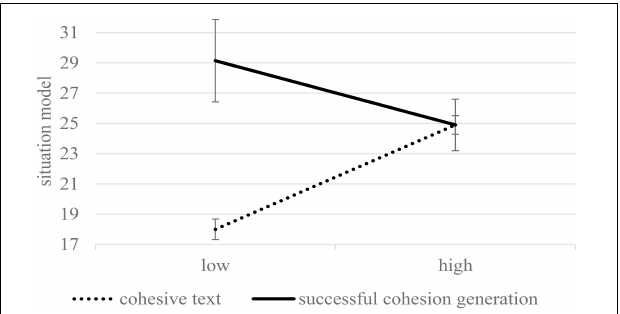
FIGURE 7 | The situation model (collapsed across immediate and delayed testing) as a function of condition and the level of reading skill (estimated means and standard errors for –1 SD and +1 SD). In contrast to Figure 3 , only learners who successfully generated (+1 SD) were analyzed. Maximum performance was